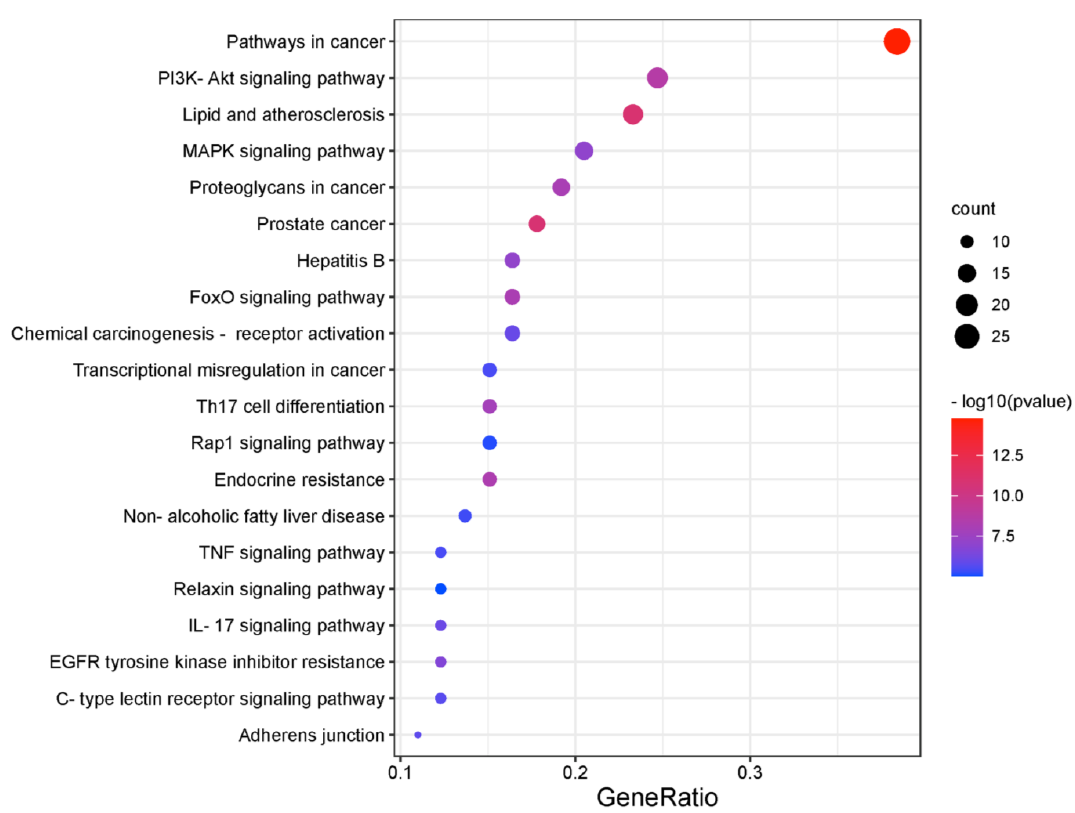
Figure 3 . KEGG pathway enrichment analysis of intersecting targets of costunolide and AIH .